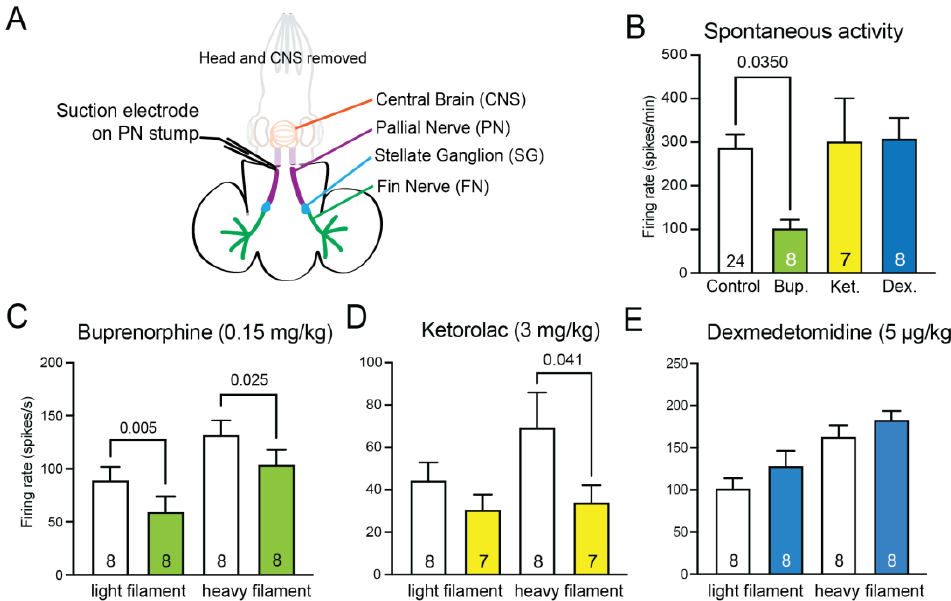
Figure 3. Peripheral nervous system excitability is suppressed by systemic analgesics. ( A ) A schematic of the nerve/tissue prep. The mantle was split down the midline and left and right sides were paired drug/control replicates. Drug-treated preparations were incubated in the same drug concentrations as shown in Figure 2, and controls were incubated in filtered artificial seawater. The large pallial nerve carries information to the central brain from the mantle nerves, which converge into the stellate ganglion. A suction electrode on the pallial nerve measures activity in response to stimulation on the mantle and fin tissue with von Frey filaments. ( B ) Spontaneous afferent firing was recorded for one minute prior to any stimulation being delivered. Only high-dose buprenorphine suppressed spontaneous activity (unpaired t -test vs control). ( C ) Buprenorphine suppressed evoked firing in response to touch with a light von Frey filament, which activates mechanoreceptors, and with a stiff von Frey filament, which activates nociceptors (paired t -tests vs. control-side prep). ( D ) Ketorolac suppressed nociceptor firing but had no effect on low-threshold mechanoreceptors. ( E ) Dexmedetomidine had no effect on pallial nerve activity. Bars show mean and error bars show standard error of the mean (SEM).